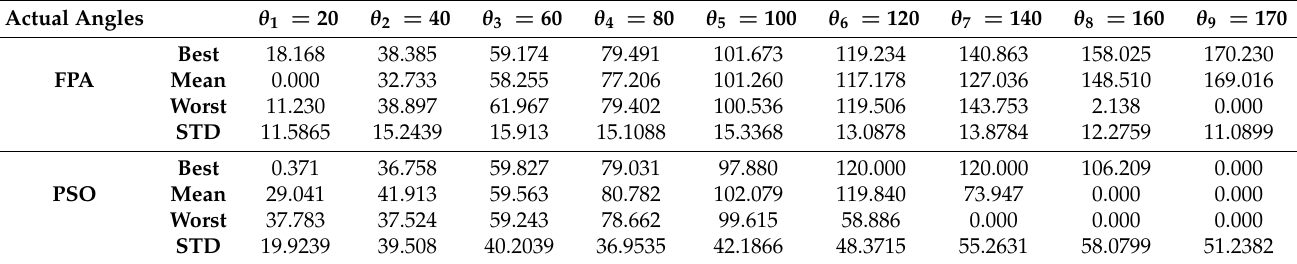
Table 6. Estimation accuracy and STD for nine targets at SNR = − 10 dB.